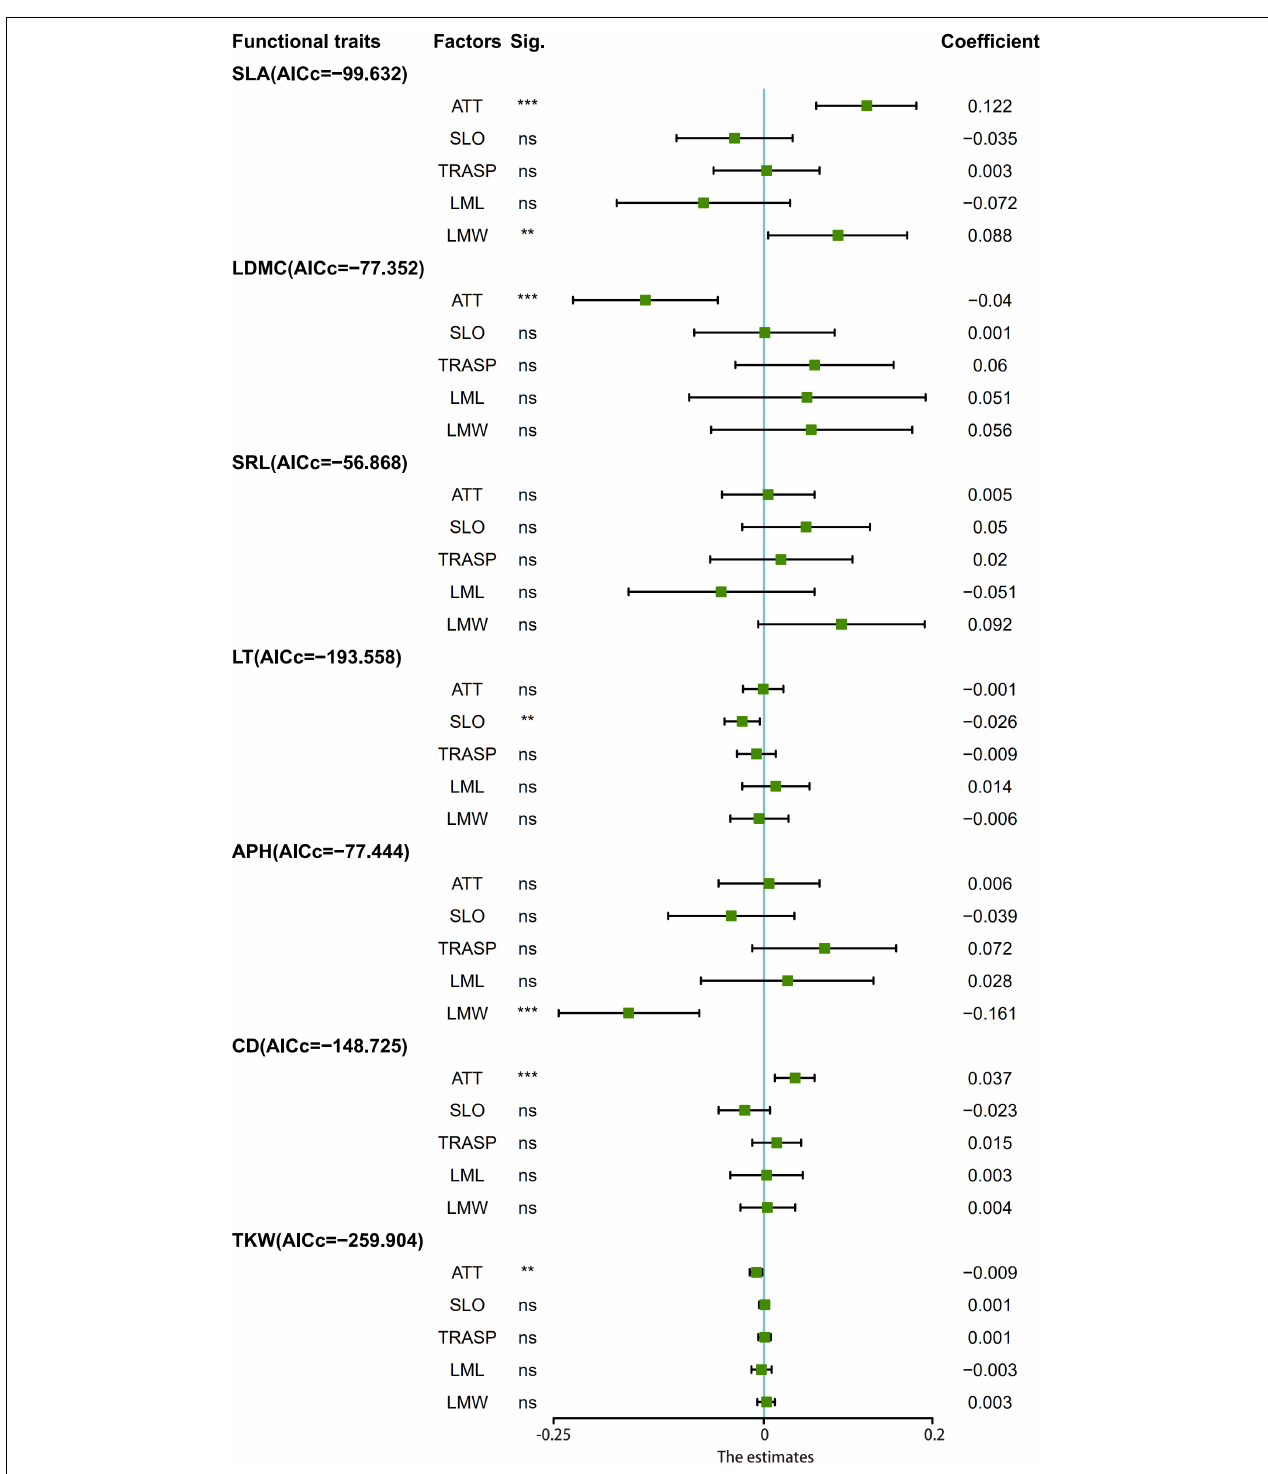
FIGURE 8 | Generalized linear mixed model (GLMM) model coefficient estimates and 95% confidence intervals showing the influence of the geographical environmental attributes of landslide no the herb functional traits. SLA, specific leaf area; LDMC, leaf dry matter content; SRL, specific root length; LT, leaf thickness; APH, average plant height; CD, crown diameter; TKW, thousand kernel weight; ATT, altitude; SLO, slope; TRASP, transformation of aspect; LML, length of landslide mass; LMW, width of landslide mass; **, significant at the 0.05 level; ***, significant at the 0.01 level; ns, non-significant.